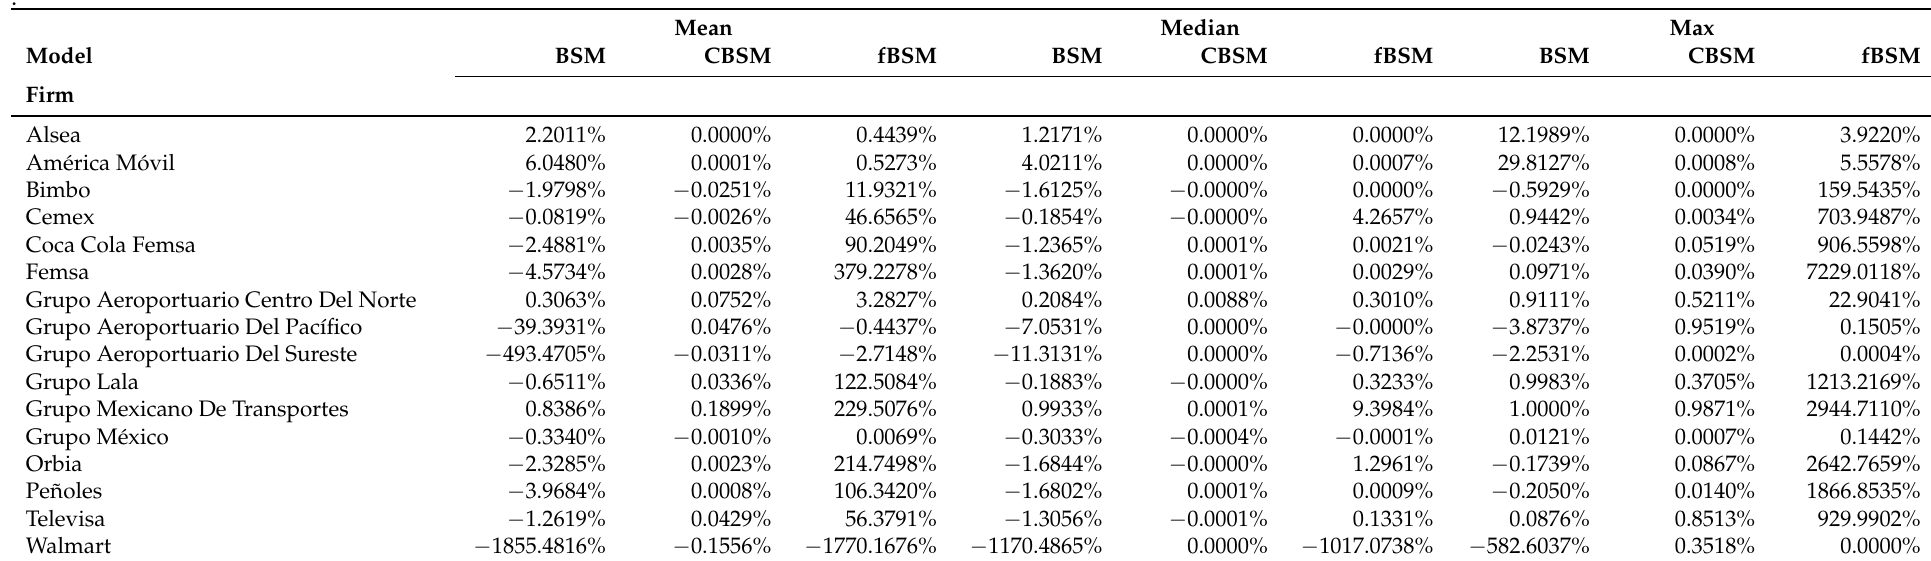
Table 3. Aggregate measures of error over all maturity dates for each firm and